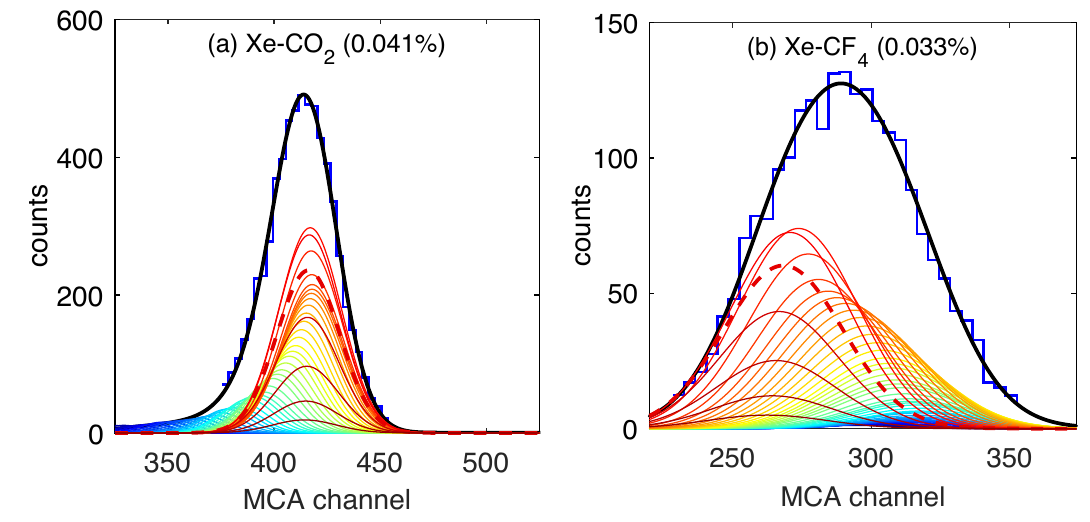
Figure 2 . Scintillation spectra obtained with an MCA for 5.9 keV x-rays absorbed in the GPSC for: (a) a mixture of Xe with 0.041% of CO 2 , at 1.15 bar and E=p = 3.1 kV/cm/bar; (b) a mixture of Xe with 0.033% of CF 4 , at 1.20 bar and E=p = 2.8 kV/cm/bar. The response function (in black) is a (cid:12)t to the to the experimental distribution (in dark blue), resulting from the sum of 5000 Gaussian curves (solid thin lines from red to blue, not at vertical scale). The dashed curve is the Gaussian corresponding to 2.5 cm path length, from which the corrected energy resolution is obtained. Corrected values of 8.3% for Xe-CO 2 and 18.7% for Xe-CF 4 were obtained, to be compared to uncorrected values (black curve) of 8.7% and 21.6%, respectively. The estimated attachment probability is 7% for the Xe-CO 2 mixture and 80% for the Xe-CF 4